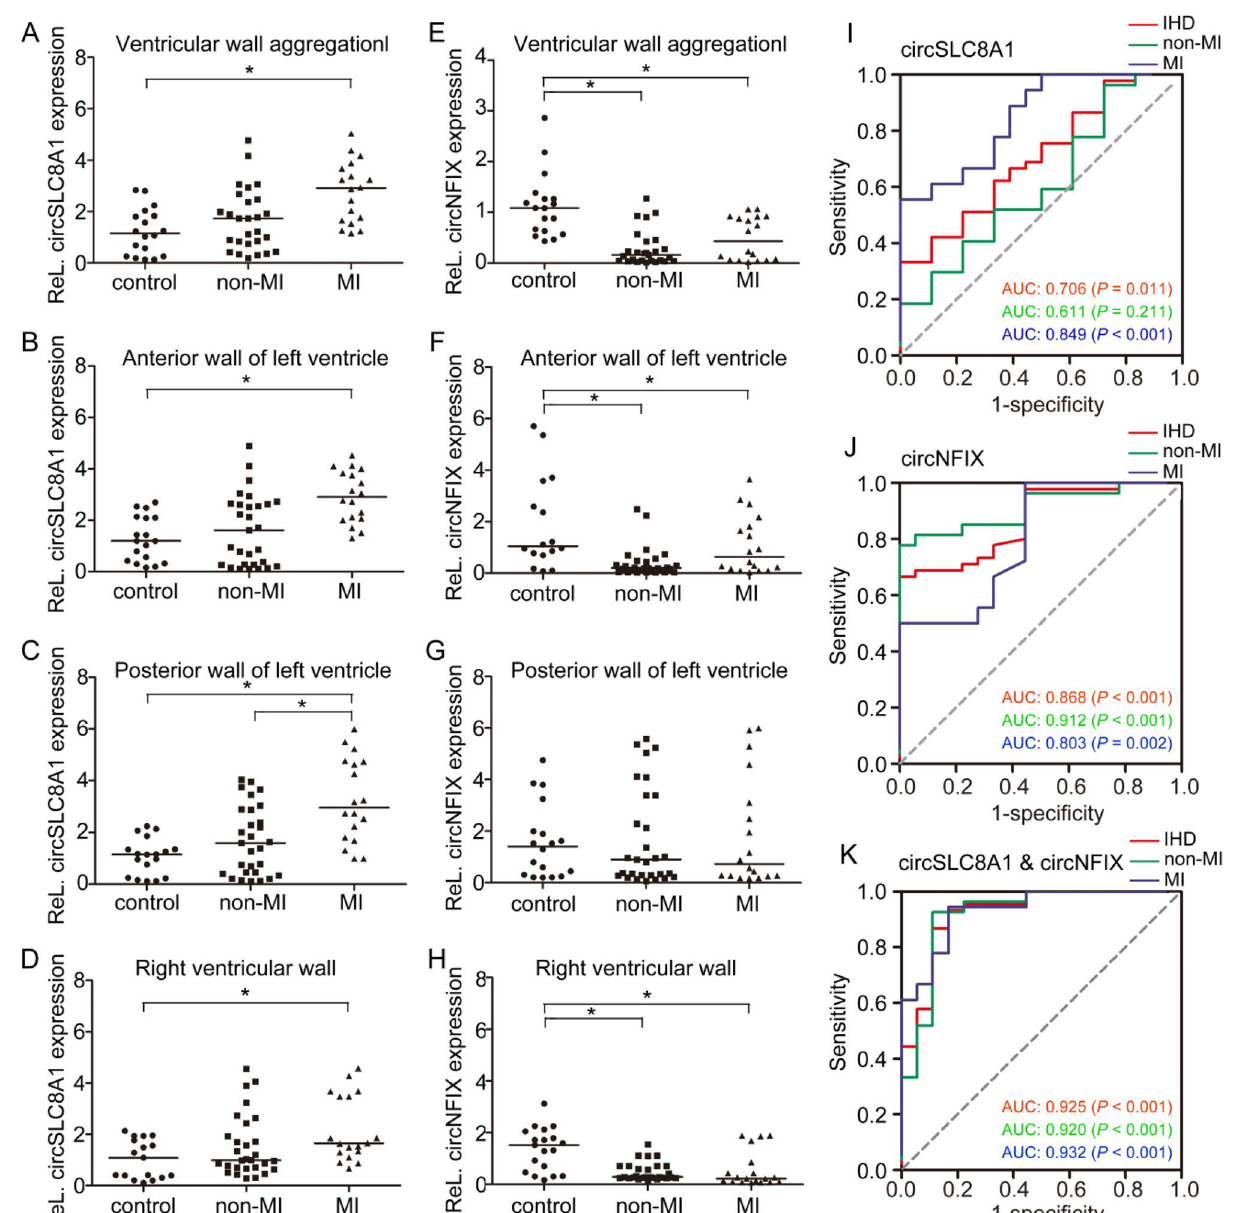
Figure 5. Relationship between circSLC8A1 and circNFIX quantification and the cause of death. Numbers in each group: control = 18; non-MI = 29; MI = 18. (A–D) Expression of circSLC8A1 in myocardium. The circRNA level in the whole ventricular wall was calculated based on the mean ΔCT value for each ventricular wall. (E–H) Expression of circNFIX in myocardium. (I) ROC curves of circSLC8A1. (J) ROC curves of circNFIX. (K) ROC curves of the combination of circSLC8A1 and circNFIX. Differences between groups were analyzed using Mann–Whitney U-test. * P < wall of the left ventricle, and right ventricular wall, respectively. SCD cases caused by acute IHD were divided into MI group and non-MI group, according to the cause of death based on forensic diagnosis. The correspond- ence between forensic autopsy cases and IHD rat models was shown in Supplementary Fig. S2 online. Compared to the control group, the MI group exhibited significantly higher circSLC8A1 expression, but the difference in circSLC8A1 expression between the non-MI group and control group was not significant (Fig. 5A–D). As for circNFIX, overall, its expression was significantly decreased in both the non-MI and MI groups compared with that in the control group, but there was no difference in circNFIX expression between the non-MI and MI groups (Fig. 5E). The circNFIX levels in cardiac tissues from the anterior wall of the left ventricle and right ventricle were consistent with the overall circNFIX level, but there was no significant difference in circNFIX level between these tissues and cardiac tissue from the posterior wall of the left ventricle (Fig. 5F–H).